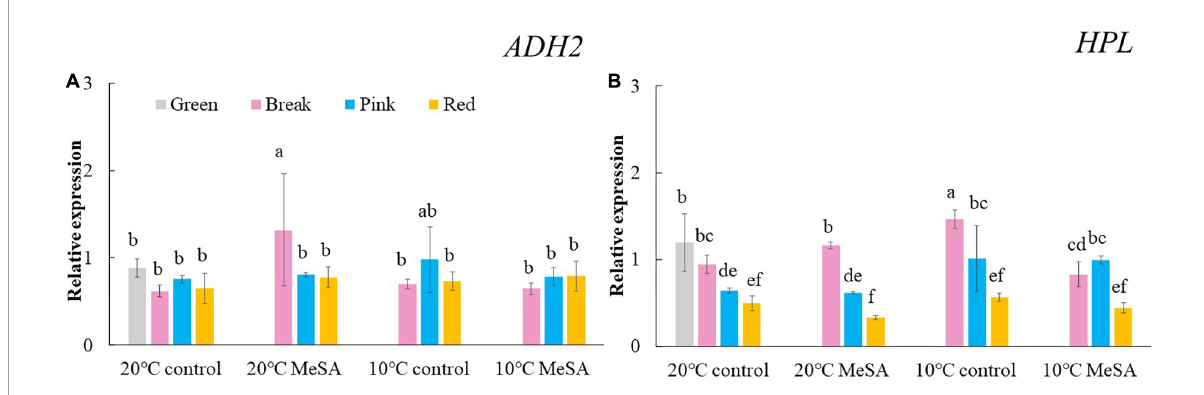
FIGURE4 Effects of methyl salicylate (MeSA) pre-treatment on the relative expressions of ADH2 (A) and HPL (B) genes in tomato fruits stored at low temperature. Data are expressed as mean ± SD ( n = 3), repeated measures one-way ANOVA followed by DMRT. Data marked with the same letter were no significant difference at p < 0.05.